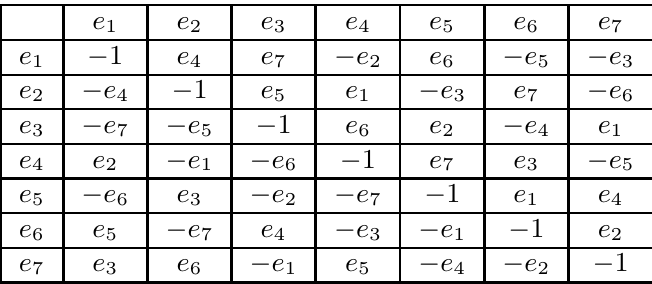
Figure 2 . Cartan-Schouten-Coxeter octonion multiplication